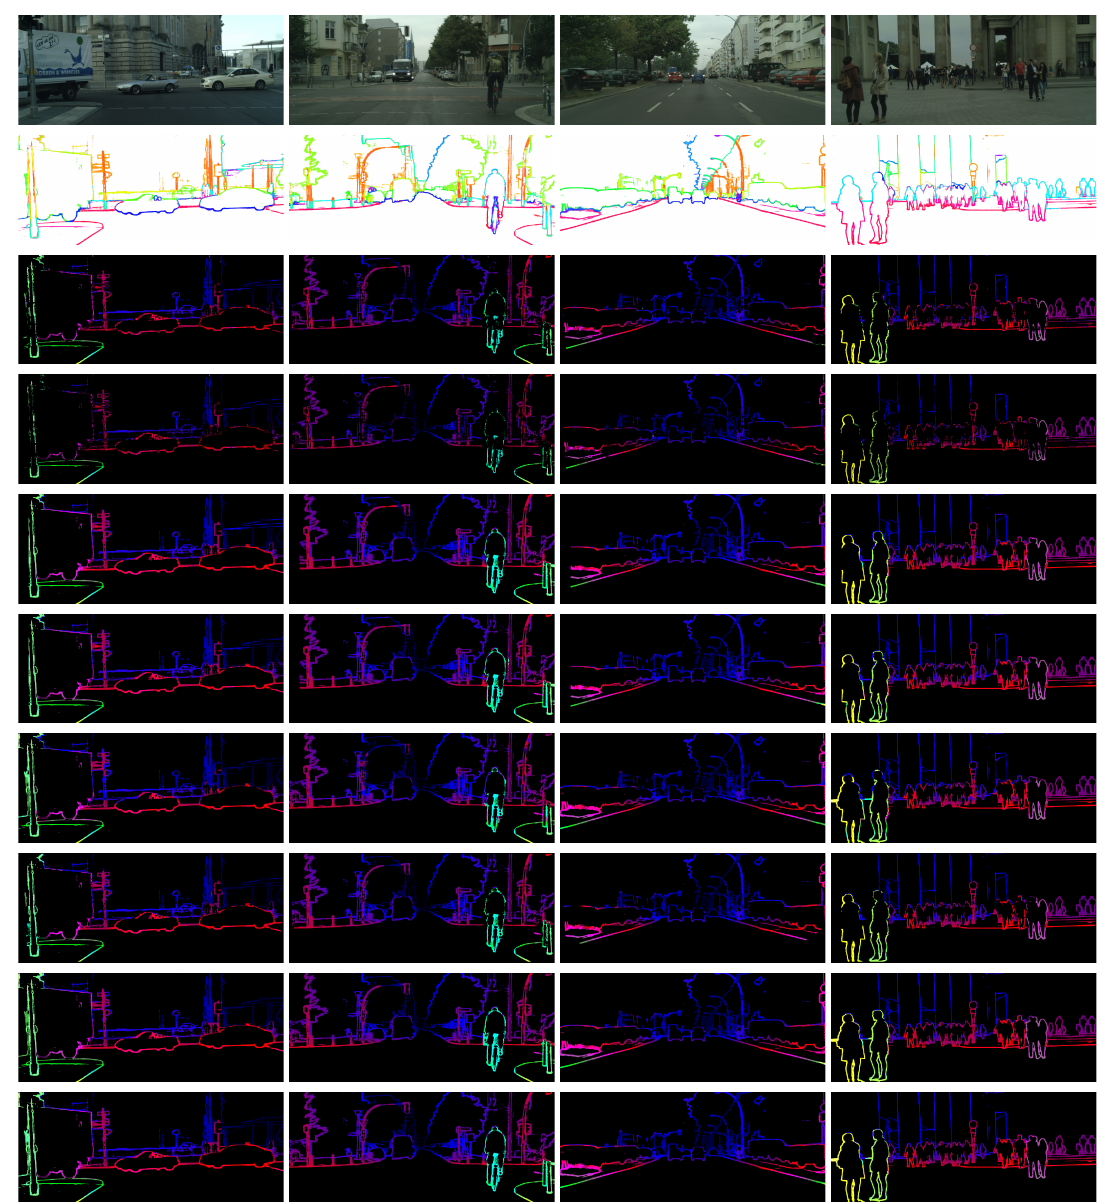
Figure 8. Examples of comparison between our method and other methods. From top to bottom: the left images, the semantic edges, the disparity maps of the following methods separately: SAD + 0.1Census + ADP (LRC), SAD + 0.1Census + ADP (SLRC), SAD + SGM + Refinement, Census + SGM + Refinement, MeshStereo [35], ELAS [36], SPSStereo [37], MC-CNN-fast